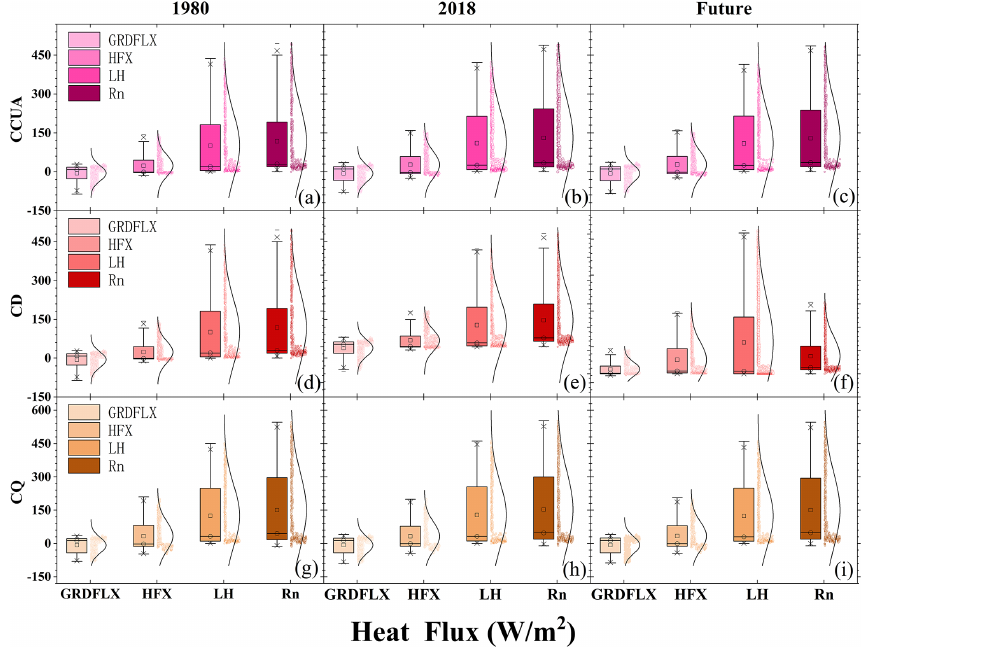
Figure 12. The heat flux distribution changes in surface heat flux over the land use grids of (a) 1980, (b) 2018 and (c) future of the Chengdu– Chongqing urban agglomeration. The heat flux distribution changes in surface heat flux over the land use grids of (d) 1980, (e) 2018 and (f) future of Chengdu. The heat flux distribution changes in surface heat flux over the land use grids of (g) 1980, (h) 2018 and (i) future of